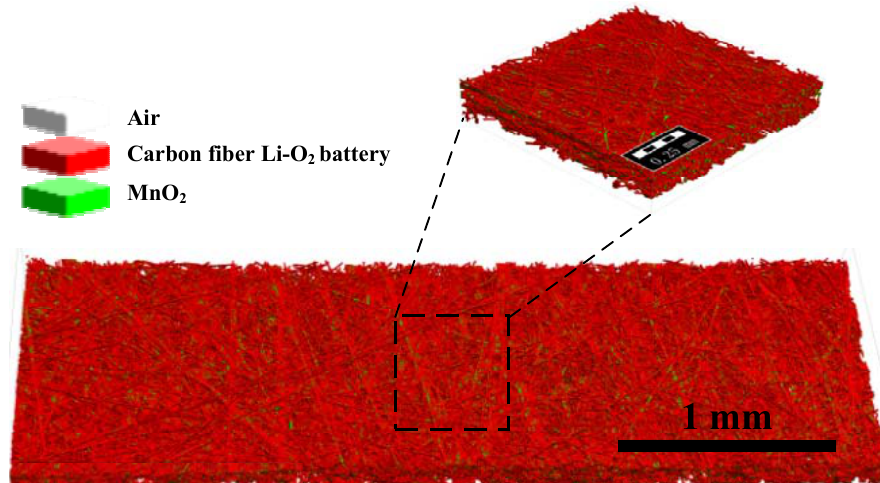
Figure 2. Morphology of composite electrode.